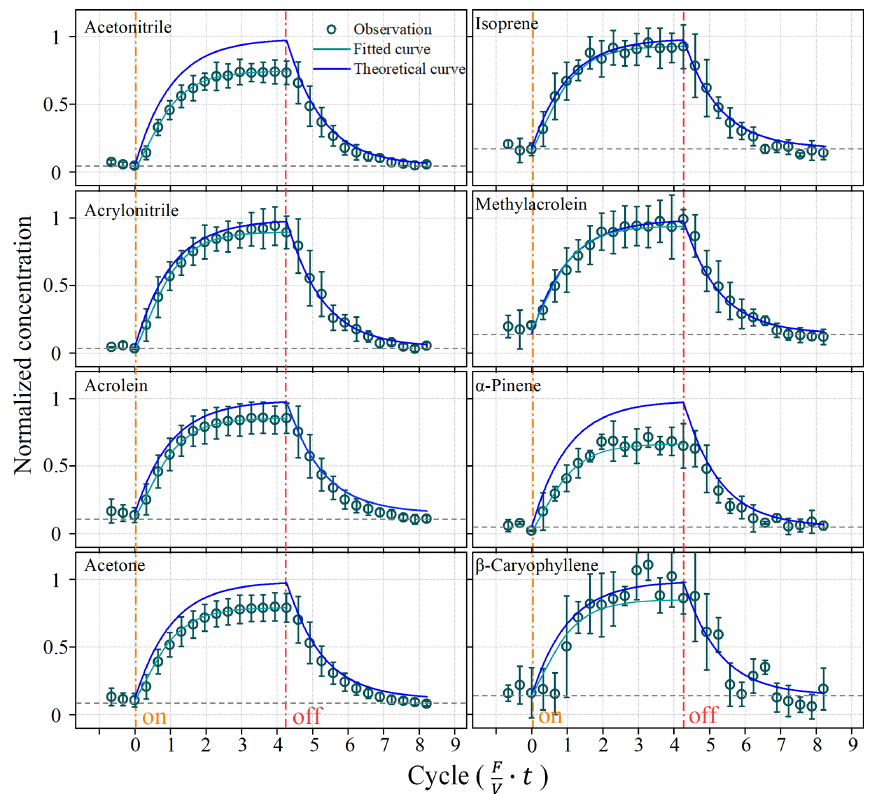
Figure 3. Changes in BVOC concentrations in the chamber during lab simulation experiments. The dashed black lines are background con- centrations. Solid blue lines represent the theoretically predicted BVOC concentrations in the chamber. The green circles are concentrations measured by the PTR-ToF-MS. Solid green lines represent fitted BVOC concentrations in the chamber.